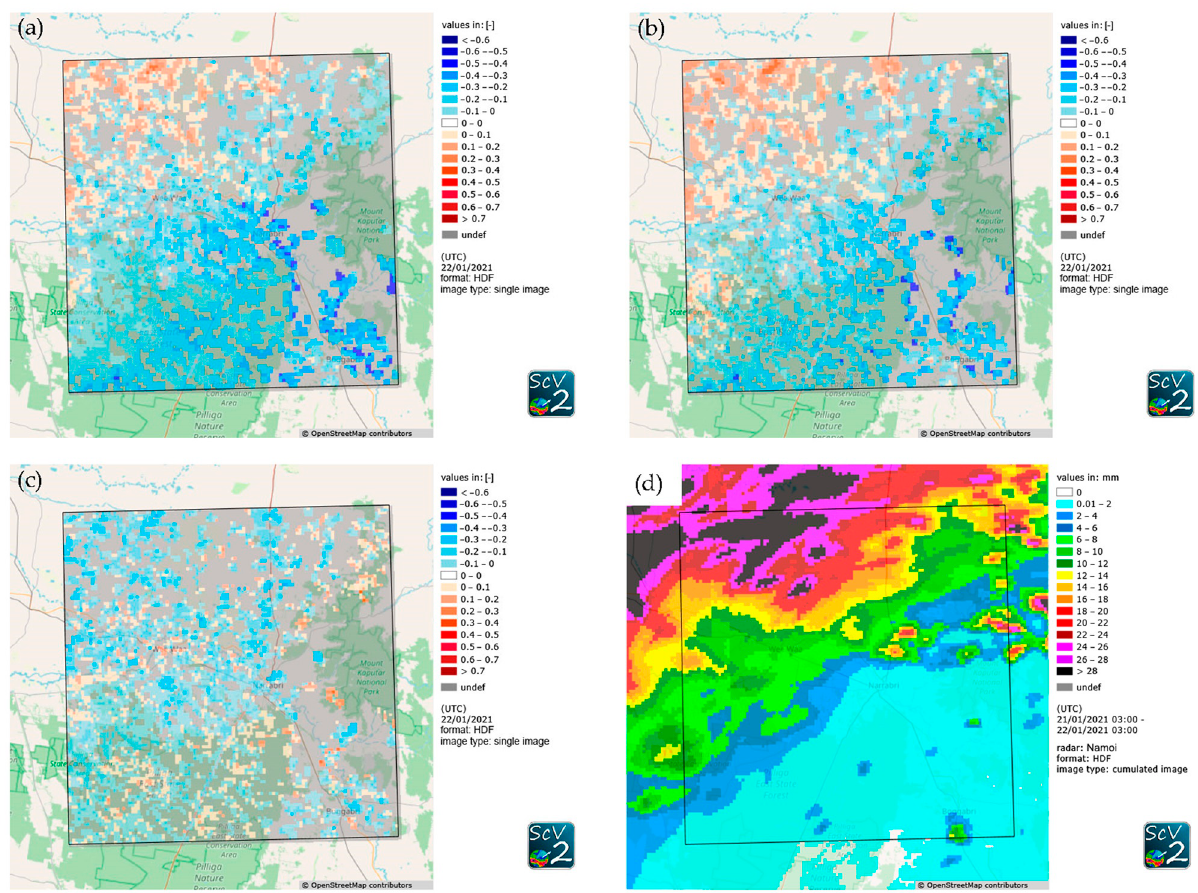
Figure 10. Relative soil moisture change (dimensionless) calculated as the difference between con- secutive days of relative soil moisture for scenario 1 ( a ), for scenario 2 ( b ), and from the difference between scenario 1 and 2 ( c ) for 22 January 2021. Positive values mean an increase in soil moisture, while negative values mean a decrease in soil moisture. Additionally, the respective cumulated radar precipitation is shown ( d ).